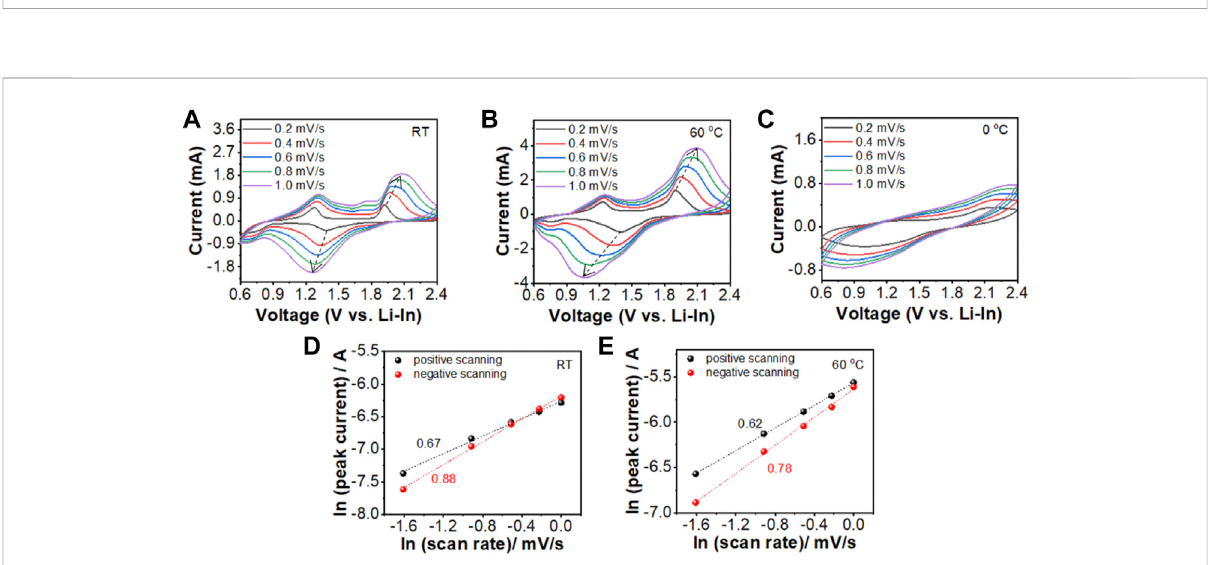
CV curves and the corresponding fi tting curves of ln (i p ) of the FeS 2 /Li 7 P 3 S 11 /Li-In battery measured with different scan rates at different temperatures (A,D) 0 ° C, (B,E) RT, and (C) 60 °